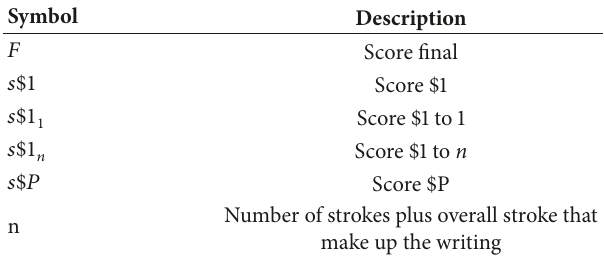
Table 9: Description of Formula Score. Symbol Description